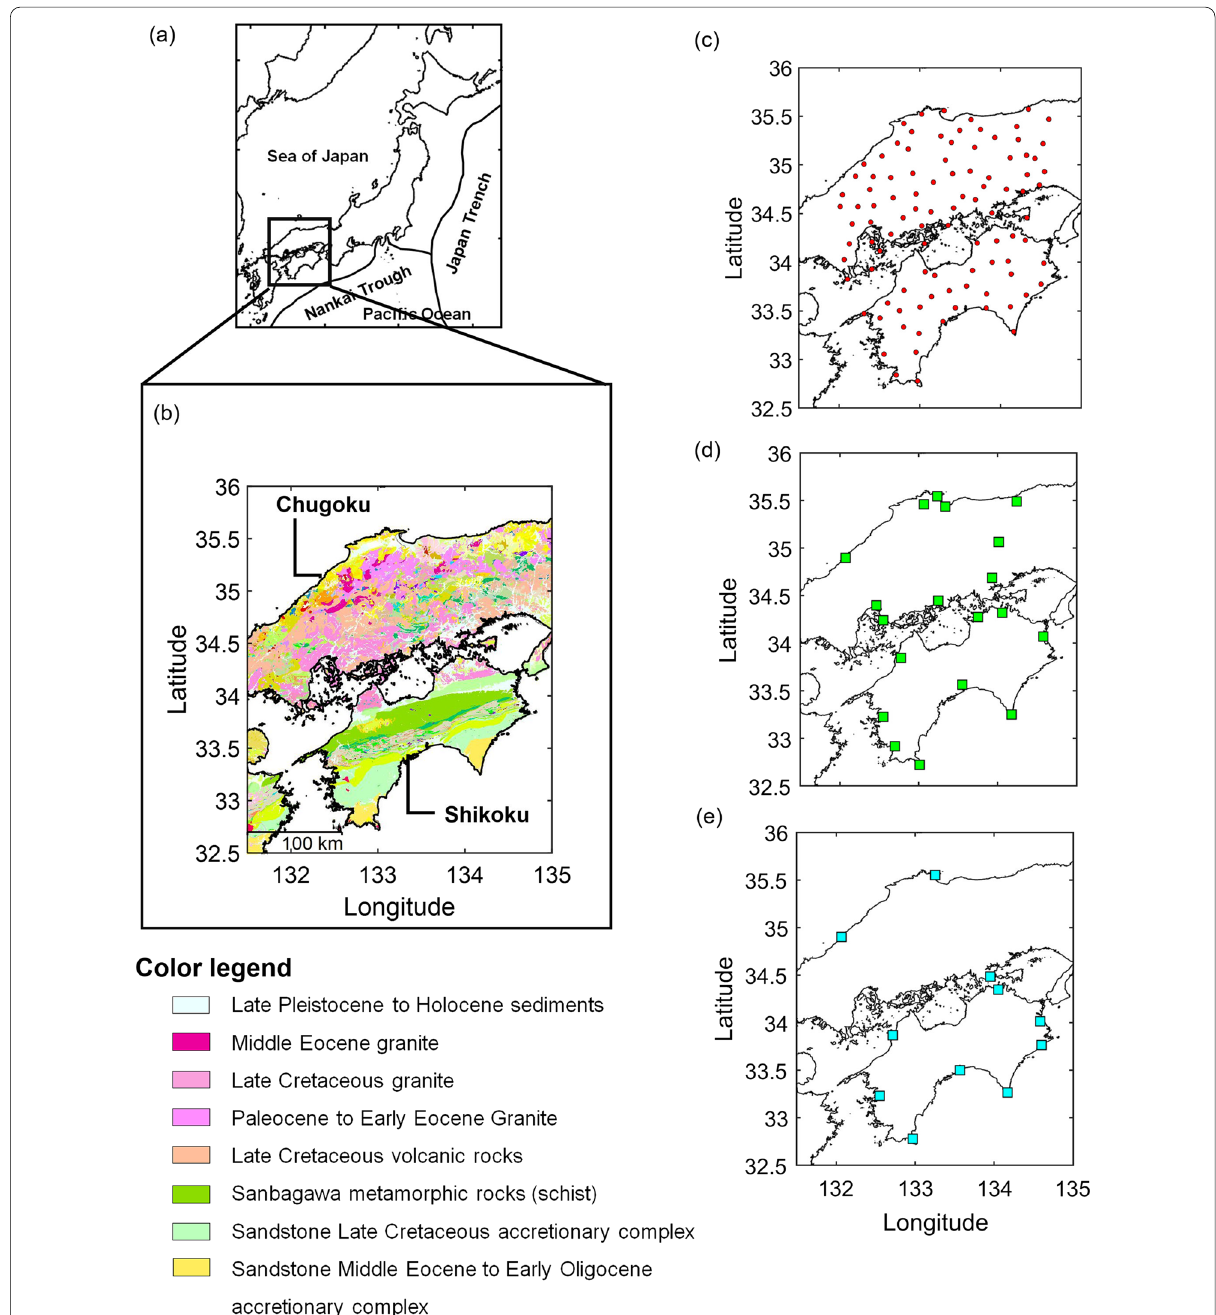
Fig. 1 a Location map of Japan showing the study area in the Chugoku and Shikoku regions, b bedrock map of the study region (modified from the Geological Survey of Japan AIST 2015), and location maps of c seismic stations, d atmospheric pressure gauges, and e ocean tidal